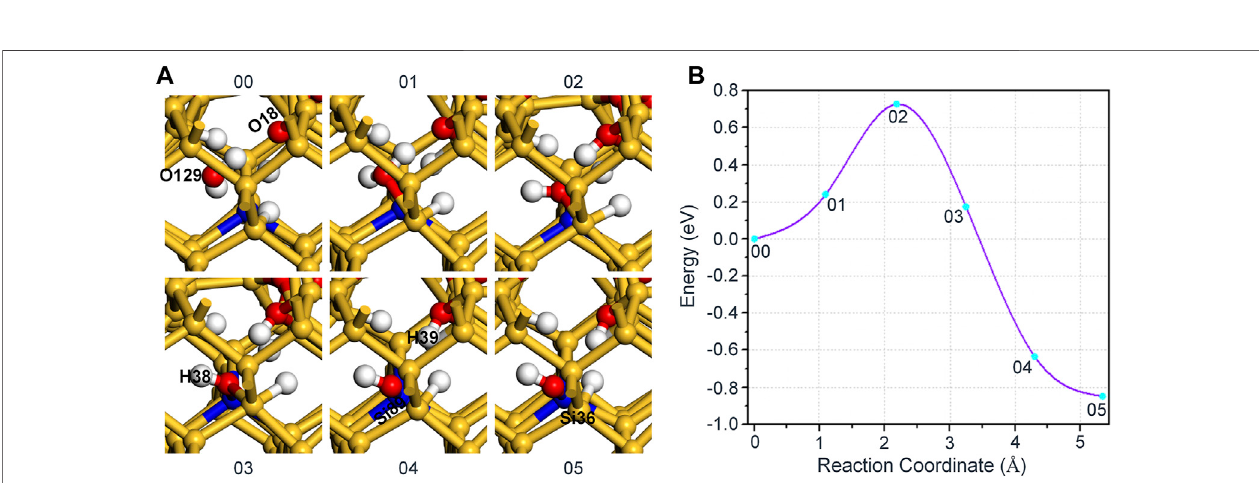
FIGURE2|(A) Theschematicdiagramofthereactionbetween P b0 defectandH 2 O.H 2 Ointheinitialstate00existsfreelyaroundthedefectatom(Si89),andthree unsaturated silicon atoms marked by green spheres in Figure 1A are passivated by the adhesion of H atoms. (B) The variation of the energy with different reaction coordinates for the reaction of H 2 O and P b0